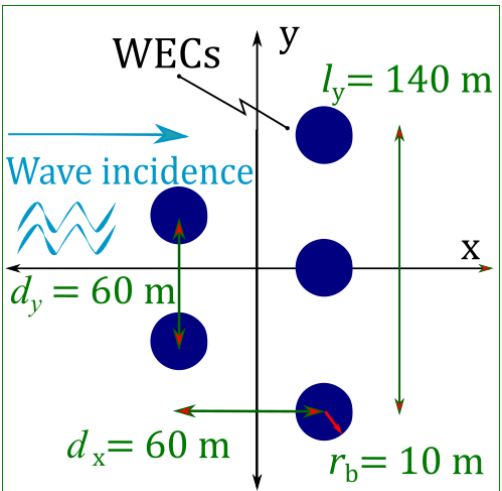
Figure 10. Plan view of the array layout for five heaving cylindrical WECs. The incident wave propagates from the left.